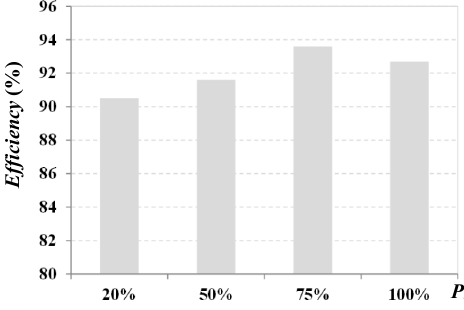
Figure 13. Test results of circuit efficiency.